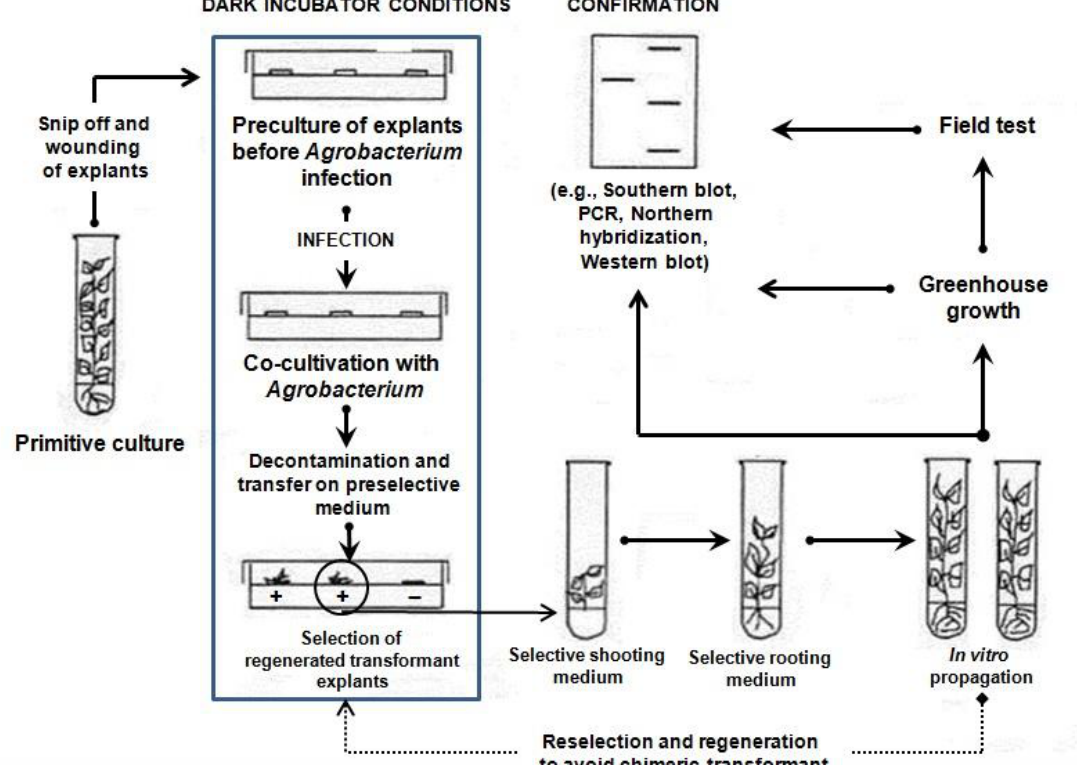
Figure 1. An overview the steps for Agrobacterium -mediated transformation in Populus